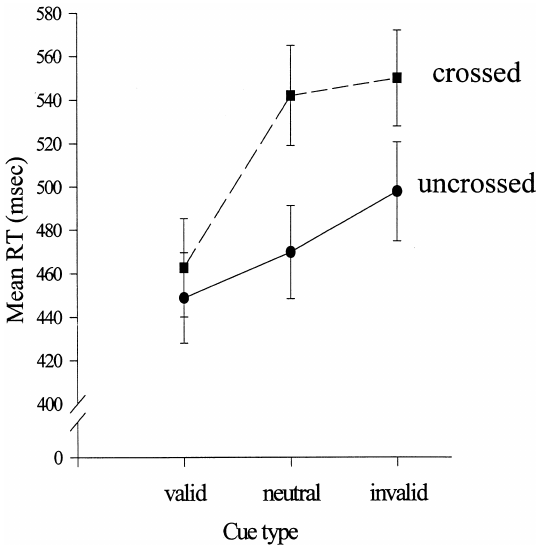
Fig. 1. Mean reaction time (msec) as a function of Cue type (valid, neutral, invalid) for uncrossed and crossed configurations. SE bars